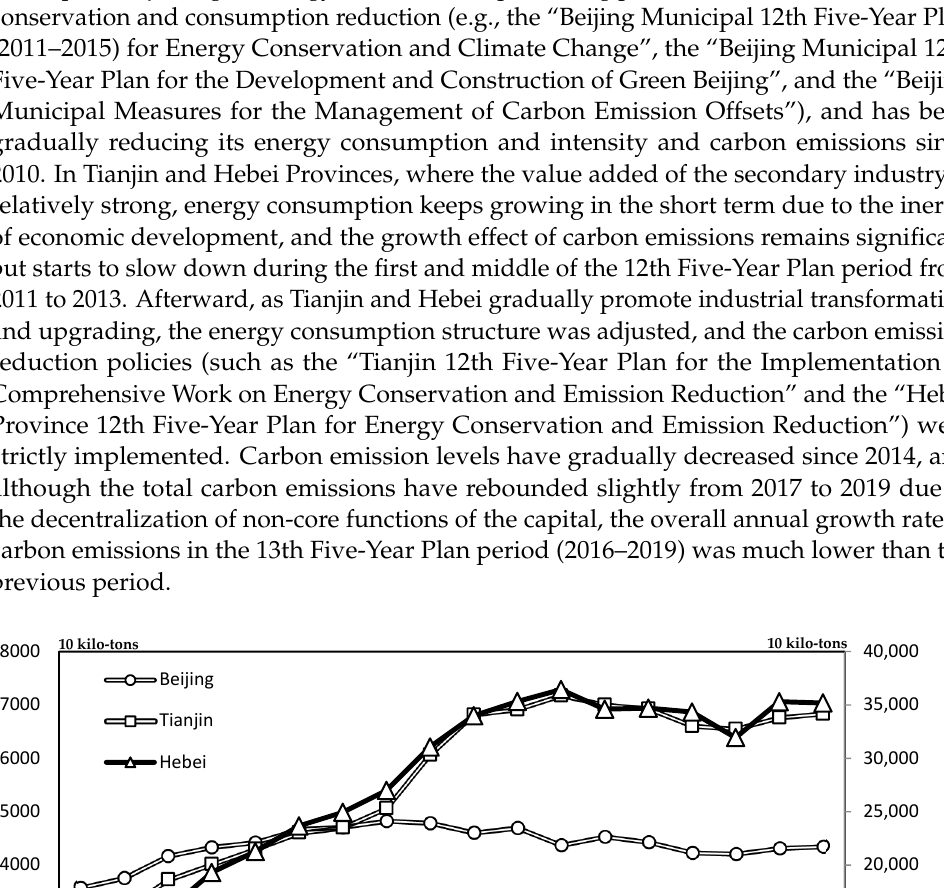
Figure 2. Changes in carbon emissions from UCL of cities in Hebei Province, during 2002–2019. 5.2. Spatial and Temporal Changes in the EEUCL in the BTH Region 5.2.1. Analysis of Results of Super-Efficiency SBM Model